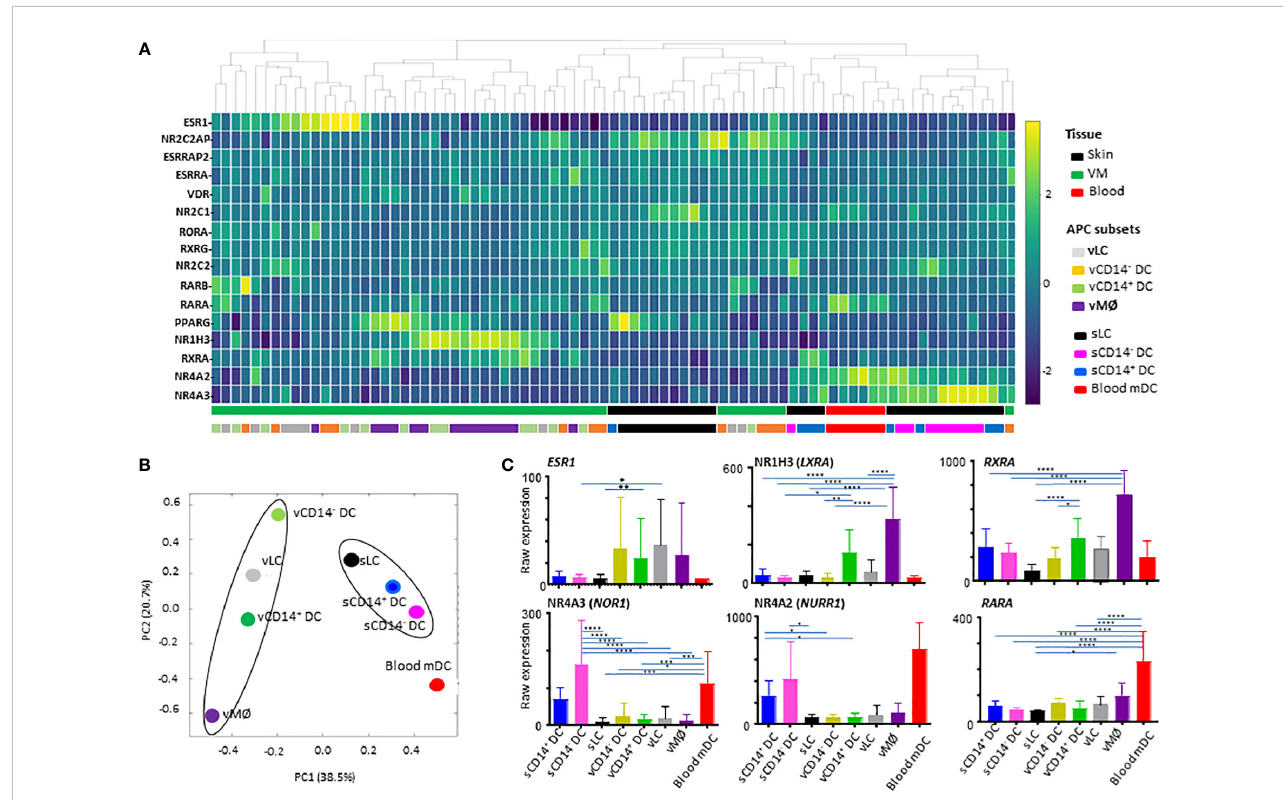
FIGURE 1 Analysis of nuclear hormone receptors (NHRs) expressed by antigen-presenting cell (APC) subsets isolated from human vaginal mucosa, skin, and blood. (A) Heatmap analysis of NHRs expressed by APC subsets (4 VM APC subsets, 3 skin APC subsets, and peripheral blood myeloid DCs). Unsupervised hierarchical clustering (Pearson correlation) of the 16 NHR transcripts differentially expressed between the 8 APC populations tested. (B) Principal variance component analysis (PVCA) for the nuclear hormone receptors differentially expressed by APC subsets. PVCA of the 81 samples analyzed, classi fi ed according to the normalized expression of transcripts identi fi ed in (A) . The samples are colored by 8 APC populations indicated. (C) Batch- corrected raw expression values for 6 NHR transcripts in (A) The expression of 10 additional NHR transcripts are presented in Supplementary Figure 2. Data are mean ± SD. Statistical analyses were performed with One-way ANOVA. n.s.: not signi fi cant, *p < 0.05, **p < 0.01, ***p < 0.005, ****p <